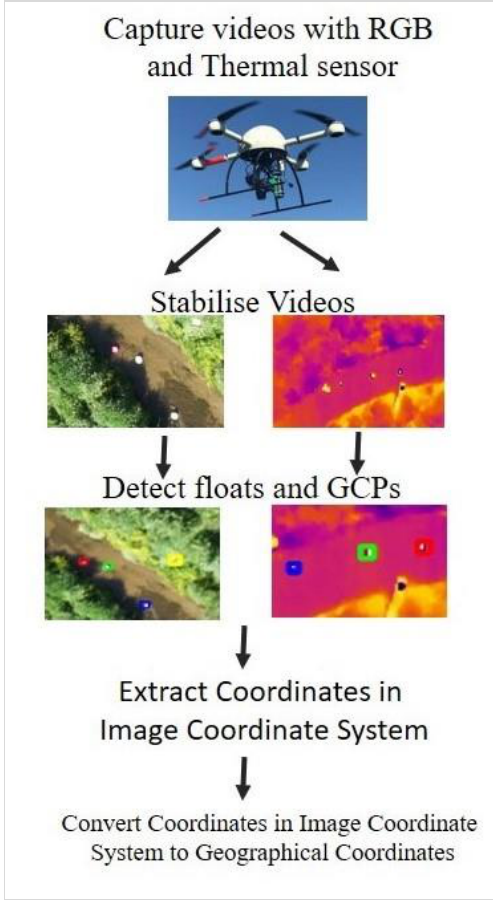
Figure 3. Generalized workflow- thermal and UAS rgb images are being matched by GCP’s, facilitating the auto-detection of floats (movement) in a geospatial